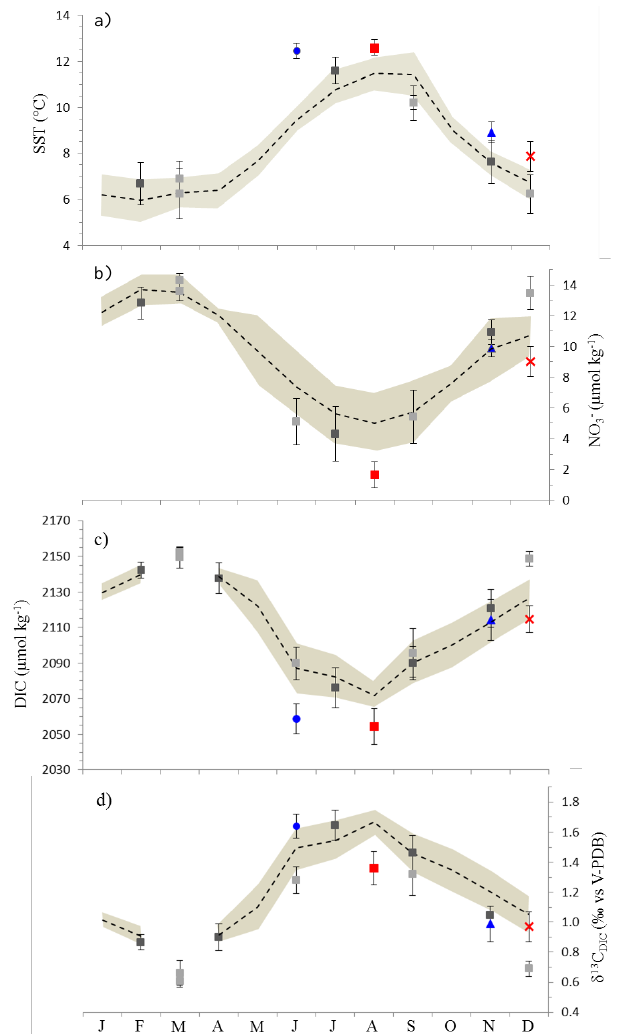
Fig. 5. Mean seasonal cycle of (a) sea surface temperature (SST), ) , (c) dissolved inorganic carbon (DIC), and (d) (b) nitrate (NO − 3 δ 13 C DIC in the surface waters of the NASPG (53 ◦ N–62 ◦ N). Light grey squares (and standard deviation) symbolize the 2010–2012 data set, whereas dark grey squares (and standard deviation) rep- resent the 2005–2006 data set. Black dashed curves and their stan- dard deviation were established from (a) the MODIS-aqua data set recorded in 2005–2006 (monthly composite with a spatial resolu- tion of 9km, generated by NASA’s Giovanni, disc.sci.gsfc.nasa.